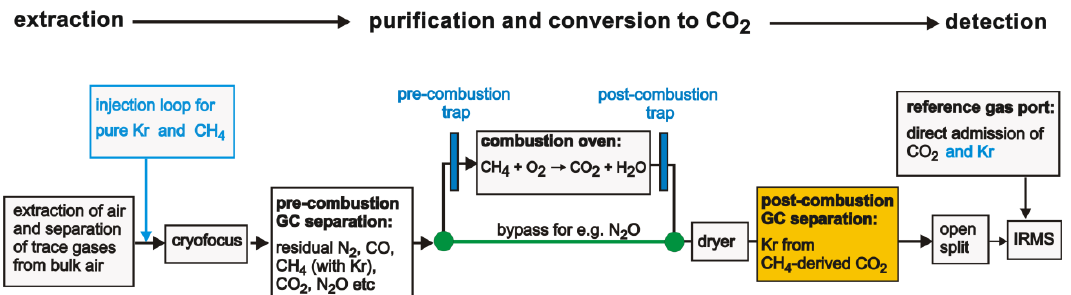
Fig. 1. Simplified flow scheme used for δ 13 C analysis of CH 4 on air samples applying the continuous-flow IRMS technique. The scheme provides an overview of basic components and specific add-ons of the systems used in this study. The analysis comprises three main steps (from left to right: extraction, purification and combustion of CH 4 to CO 2 , and finally the detection in the isotope ratio mass spectrometer). The grey boxes represent the basic components used by all laboratories and date back to the milestone publications in this field (Merritt et al., 1995; Rice et al., 2001). An exception is the IMAU system described by Sapart et al. (2011), where no pre-combustion GC is used and the separation of the gases is achieved solely by a preconcentration step. Coloured symbols denote additional devices, which are specific for the certain laboratory. Blue and green colours denote features of the Bern system, while the yellow box is specific for the updated IMAU system. The injection loop (blue box) allows injecting pure CH 4 and Kr into the GC flow to monitor the system and allow special experiments. The pre-combustion trap and the post-combustion trap were included later on into the updated Bern system to remove the Kr interference. The yellow box represents the post-combustion GC, which was included in the updated IMAU system to remove the Kr interference.